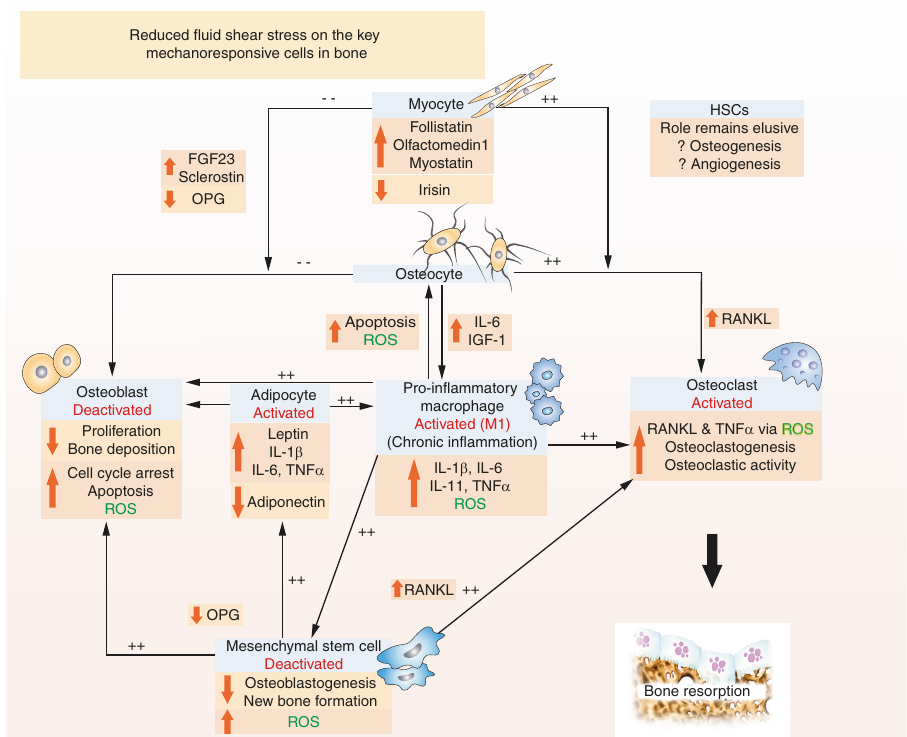
Fig. 8 Based on the current literature, it is reasonable to speculate that extremely low fl uid shear stresses induced via microgravity, alterations in osteoporotic bone architecture, and increased adiposity will together guide cells toward a phenotype that results in osteodestruction. Hypothesized mechanisms of bone loss due to extremely reduced fl uid shear stress: osteocytes release more RANKL than OPG, thereby activating osteoclastic activity and a proin fl ammatory macrophage phenotype. The reduced OPG and increased proin fl ammatory cytokine release (e.g., IL-1 β , IL-6, and TNF α ) and ROS suppress the osteogenic differentiation of MSCs as well as the proliferation and deposition of new bone by osteoblasts. Increased myostatin and decreased irisin expression further activate osteoclastic activity and inhibit osteoblastic activity. MSCs preferentially differentiate into adipocytes (via increased leptin and decreased adiponectin, for example) while secreting proin fl ammatory cytokines that contribute to maintaining the M1 macrophage phenotype. It is conceivable that the concerted response of osteocytes, osteoclasts, macrophages, adipocytes, myocytes, and MSCs, among other key cells not shown (e.g., fi broblasts and endothelial cells), will serve to keep cells within a cycle of osteodestruction. The role of mechanoresponsive HSCs remains unknown. Experimentally uncon fi rmed associations are labeled in